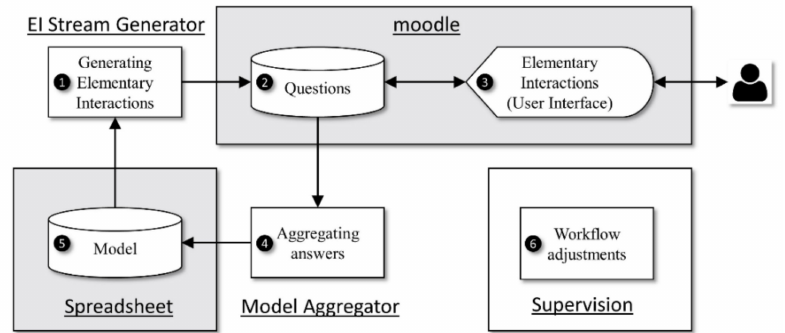
Figure 5. Workflow of core component validation.